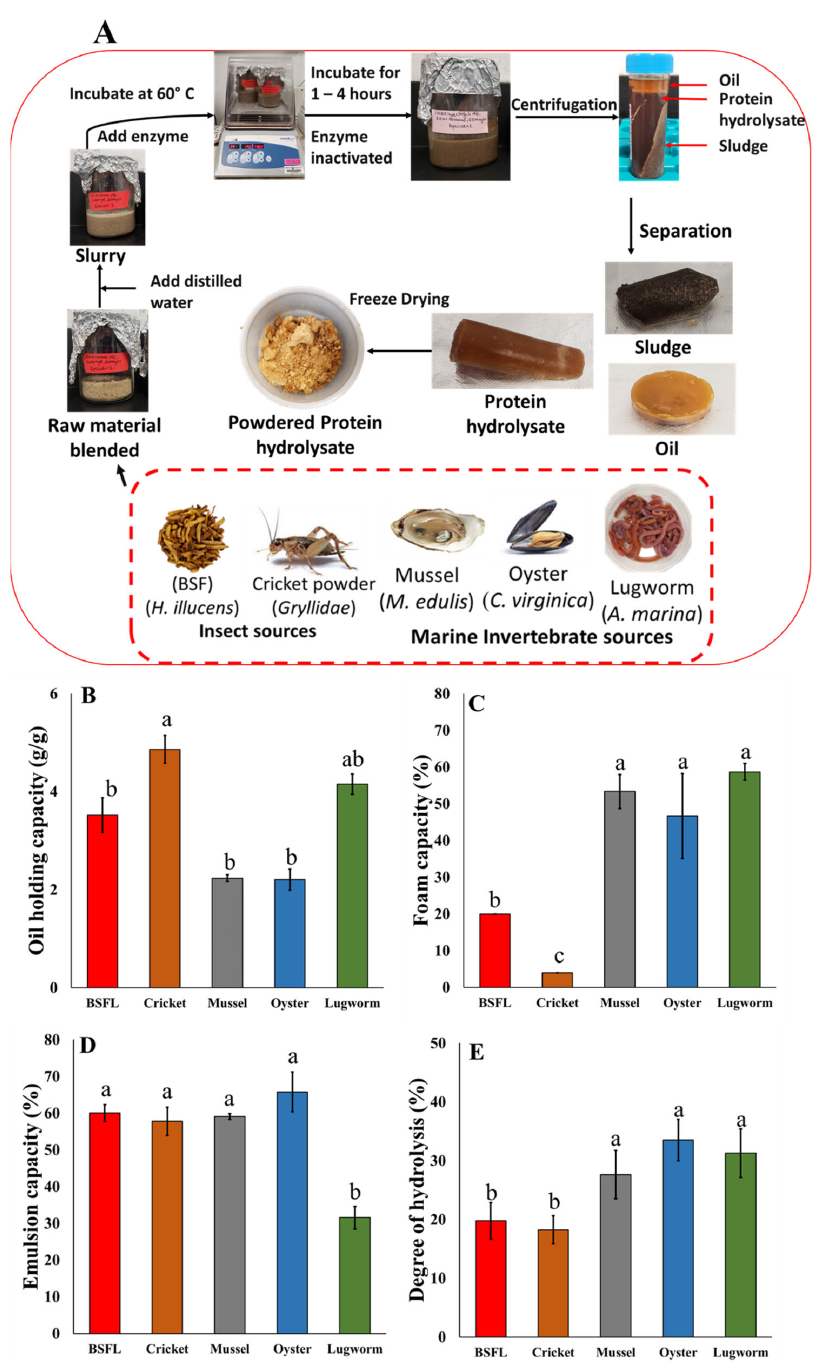
Figure 1. ( A ) Protein hydrolysates bioprocessing via enzymatic reaction; Techno-functional properties of protein hydrolysates; ( B ) oil-holding capacity; ( C ) emulsifying capacity; ( D ) foaming capacity; and ( E ) degree of hydrolysis.